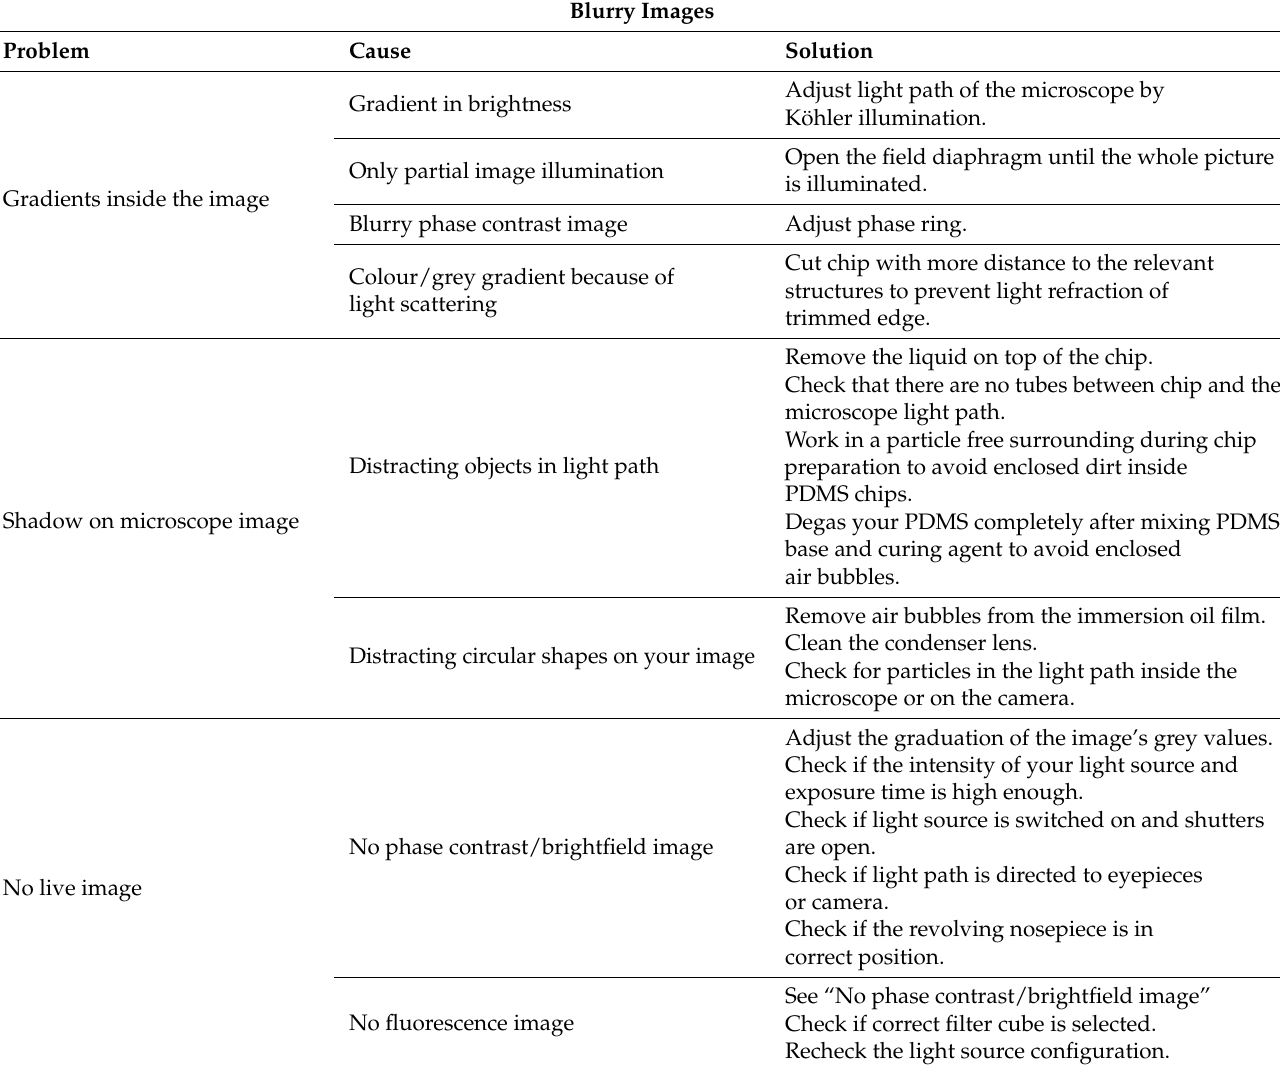
Table 10. Listed are the most frequently occurring challenges concerning blurry images with their respective cause and a suggested